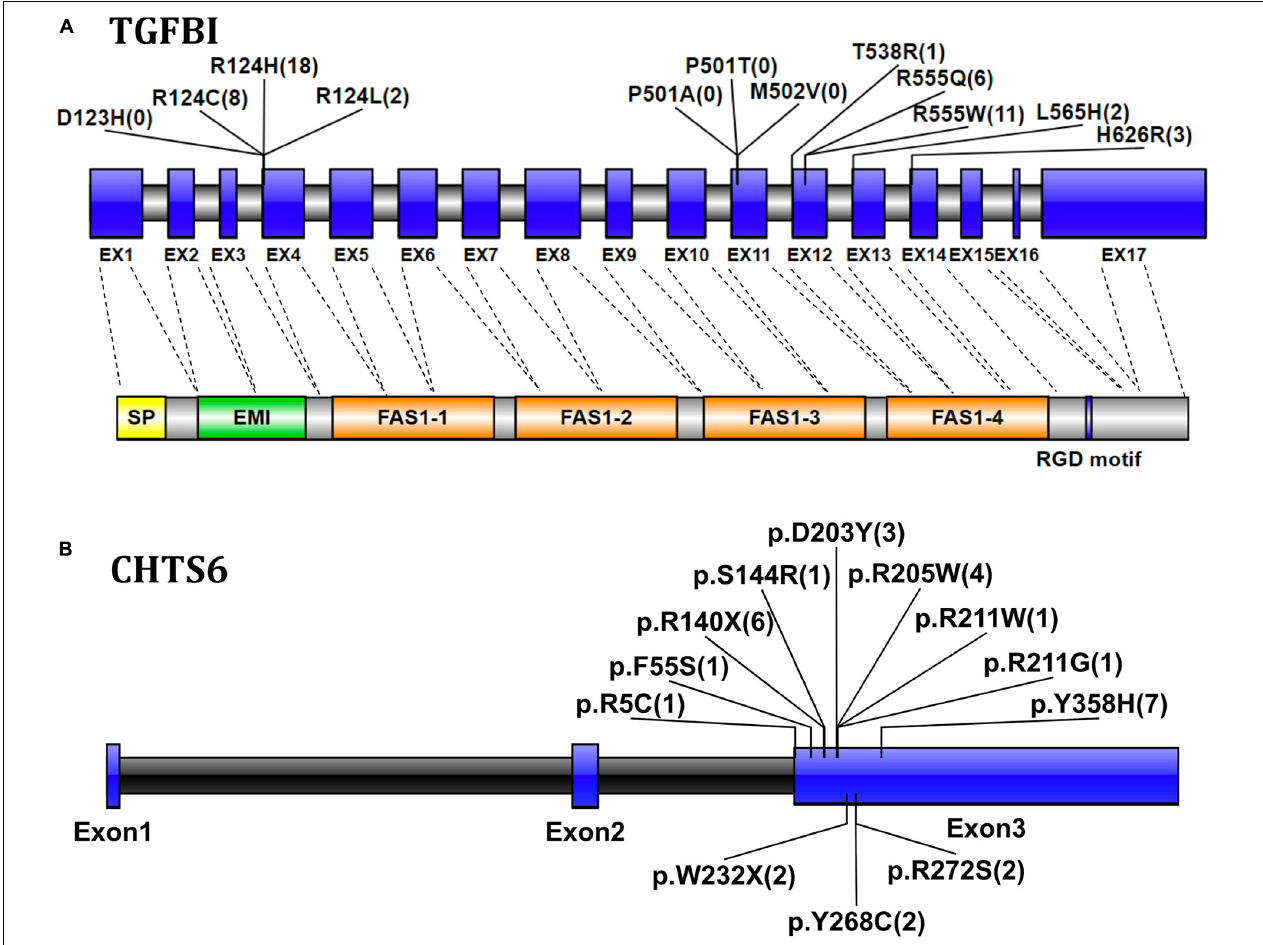
FIGURE 3 | (A) Graphical representation of the TGFBI gene and protein structure, showing the position of the detected mutation exon and the corresponding domain. The numbers in parentheses represent the number of CD patients with mutations detected. Exons are drawn to scale; introns are not drawn to scale, indicating exon–intron boundaries. Transcript NM_000358. (B) The location and number of CHTS6 mutations detected in the IED population, the numbers in parentheses represent the number of individuals with mutations detected, including 4 CD patients and 24 individuals with non-CD phenotype. Transcript